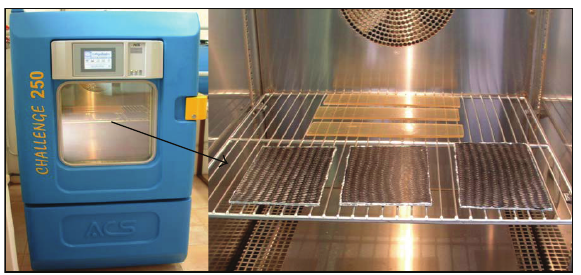
Figure 4: Running conditioning test with a particular of internal chamber.